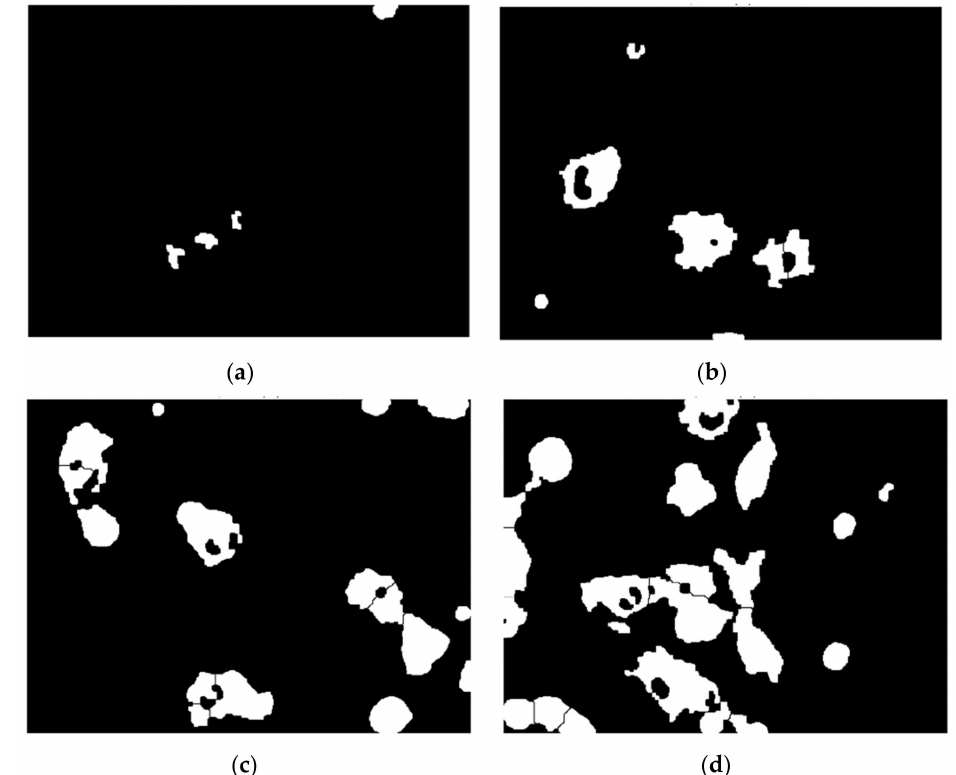
Figure 13. Set of processed images: ( a ) Stage A—control, cells detected: 4, cell area: 0.62%; ( b ) Stage B—12.5 µ g/mL, cells detected: 7, cell area: 4.76%; ( c ) Stage C—25 µ g/mL, cells detected: 16, cell area: 10.81% ( d ) Stage D—50 µ g/mL, cells detected: 22, cell area: 17.75%.